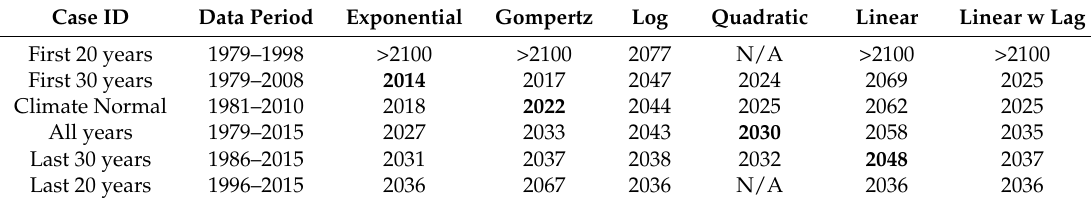
Table 4. Projected FIASYs from optimized statistical models. Entries in bold indicate projections from models with the best fit (see AICc and W information from Table 3).